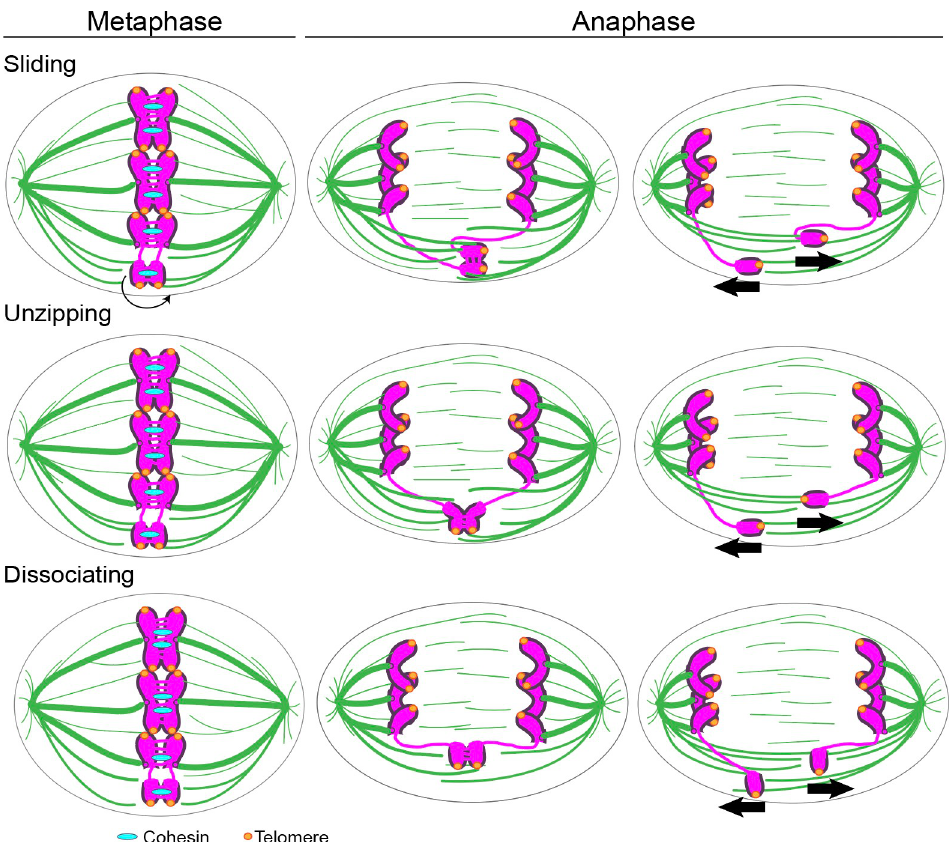
Fig 8. Schematic showing distinct modes of acentric separation. At some point during the metaphase- to-anaphase transition, acentrics that separate by sliding orient parallel to the spindle and slide past one another. This is likely driven by lateral associations between the microtubules and acentrics. The unzipping mode occurs when separation initiates at the broken end followed by separation of sister telomeres. It may be that the initial separation is driven by the DNA tether connecting the centric and acentric fragments. Separation across the entire length of the acentric is referred to as simultaneous dissociation. It may be that the DNA tether and acentric-microtubule interactions contribute equally for sister acentrics that separate by simultaneous dissociation. (Chromosomes in magenta, microtubules in green, cohesin in cyan, telomeres in